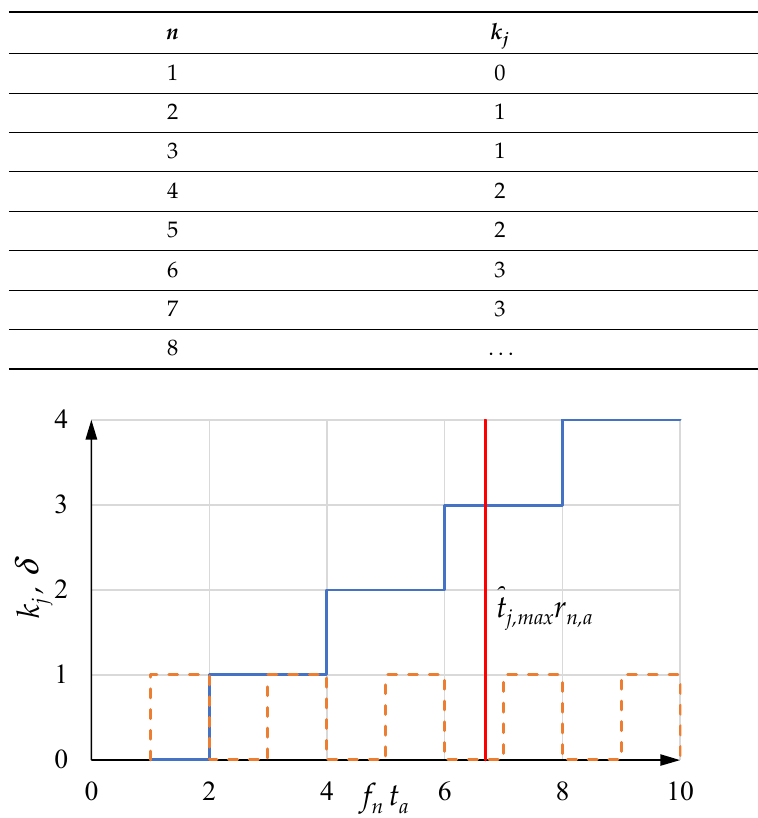
Figure 9. Values of k j and δ versus the abscissa r n , a